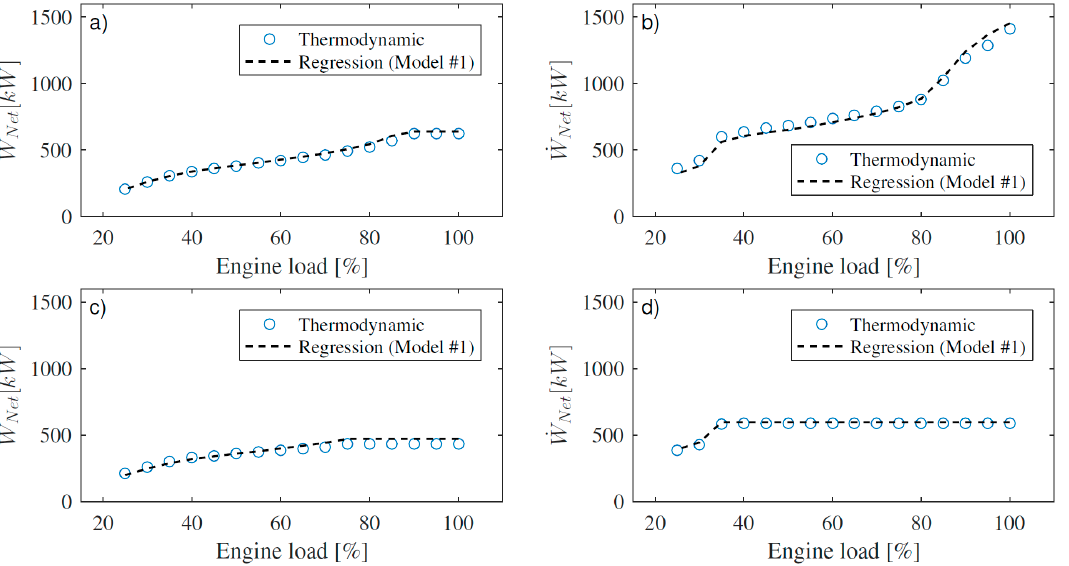
Figure 11. ORC power output as a function of the engine load estimated by the thermodynamic model and by the regression model #1: ( a ) feeder—maximization of energy production, ( b ) container vessel—maximization of energy production, ( c ) feeder—minimization of LCOE, ( d ) container vessel—minimization of LCOE.